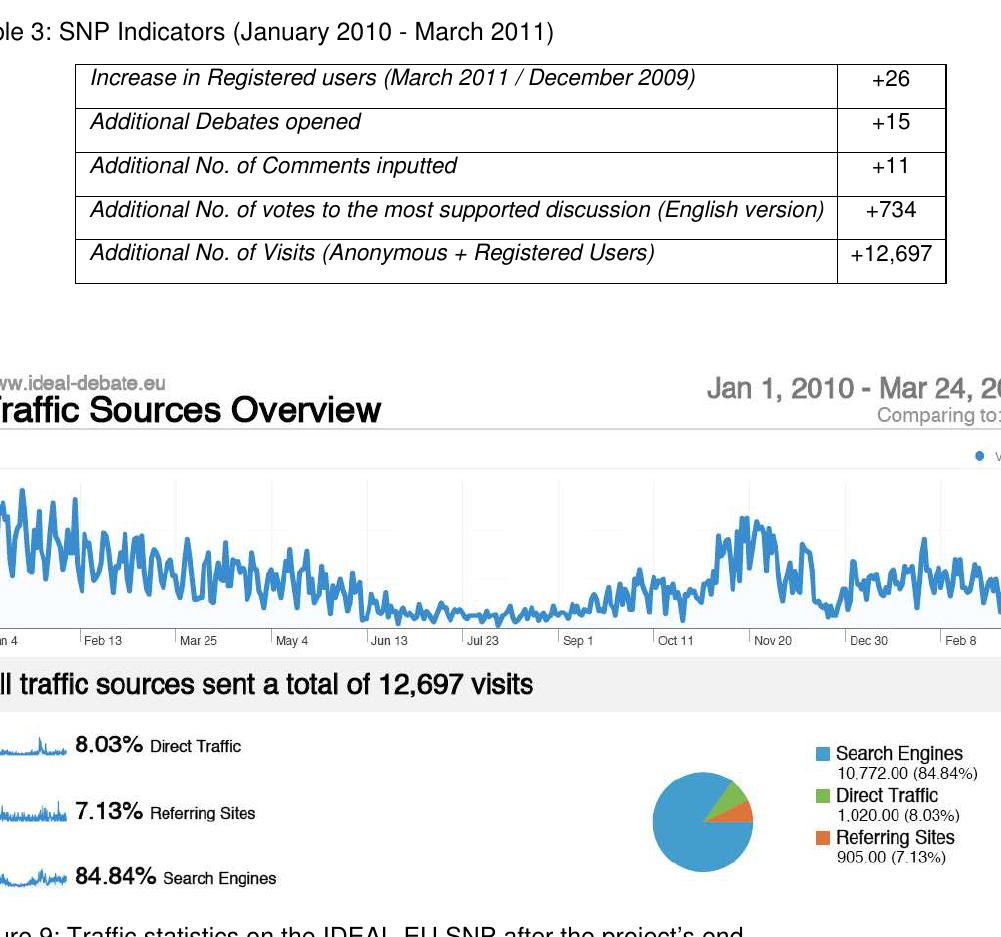
Figure 9: Traffic statistics on the IDEAL-EU SNP after the project’s